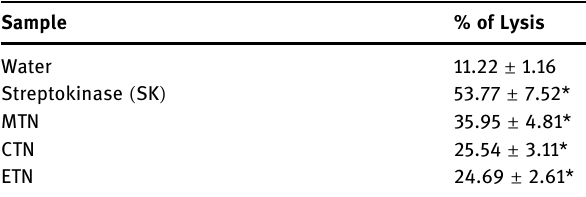
Table 2: E ff ects of T. nudi fl ora leaves extracts on in vitro clot